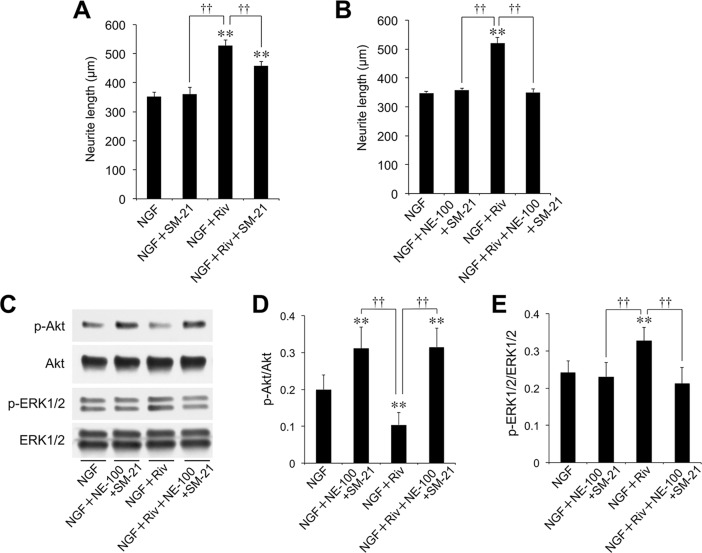
Effect of Sig-2R antagonist and additional Sig-1R antagonist on Riv-mediated enhancement of NGF-induced neurite outgrowth and phosphorylation of Akt and ERK1/2 in PC12 cells.(A) PC12 cells were pre-incubated in the presence or absence of SM-21 (10 μM) for 4 h. (B, C) PC12 cells were pre-incubated in the presence or absence of SM-21 (10 μM) and NE-100 (10 μM) for 4 h. NGF and Riv were added, and cells were incubated for an additional 24 h before neurite outgrowth and western blotting assays. (C) Total protein lysates were collected and subjected to western blotting for the assessment of the phosphorylation status of Akt and ERK1/2. (D, E) The intensity of the p-Akt polypeptide band was normalized to that of the total Akt band (p-Akt/Akt) (D), while the intensity of the p-ERK1/2 polypeptide band was normalized to that of the total ERK1/2 band (p-ERK1/2/ERK1/2) (E). For each condition, values are reported as the mean ± SD for all PC12 cells included within five randomly chosen fields. **p < 0.01 compared with NGF, ††p < 0.01 compared with NGF+Riv.